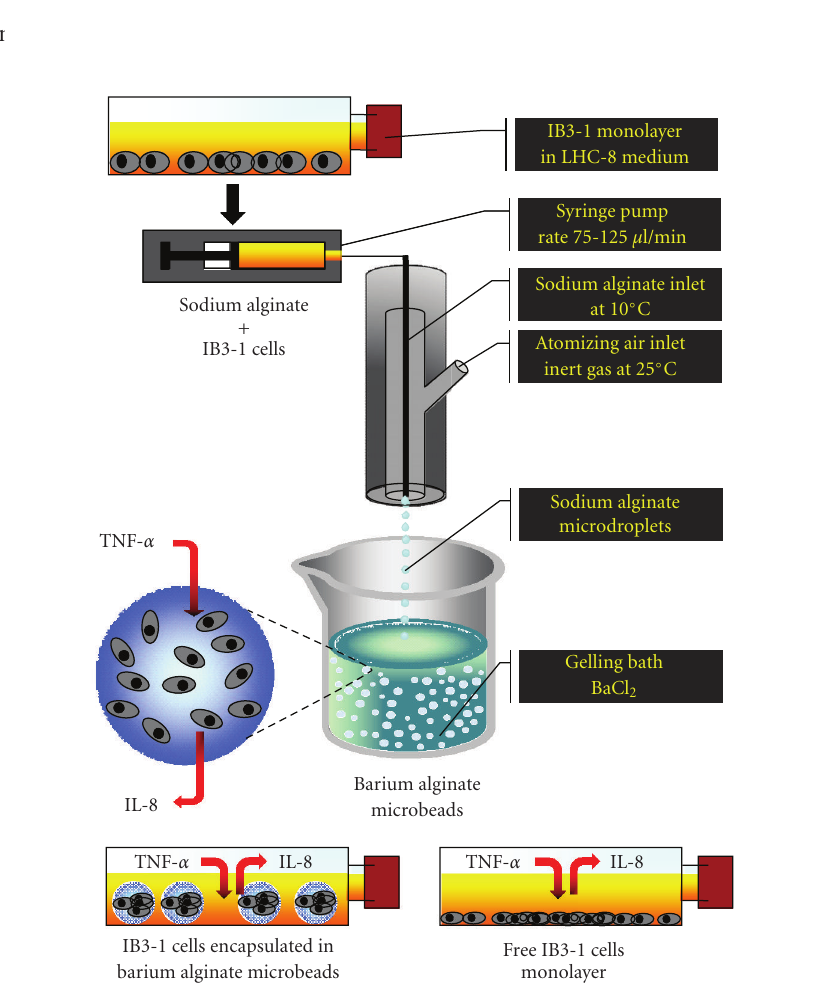
Figure 2: General scheme of the encapsulation procedure for IB3-1 cells by monojet air-driven device. The lower part of the figure summarizes the procedure for the in vitro experiments with free (right) and encapsulated IB3-1cells (left) treated with TNF-